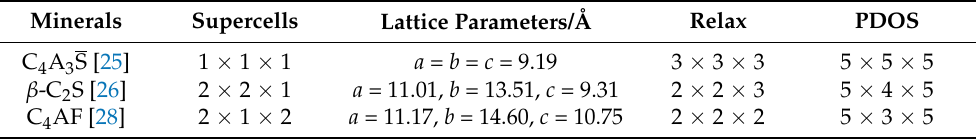
Table A1. Minerals, supercells, lattice parameters, and detailed k point meshes used for relax and partial density of states (PDOS).